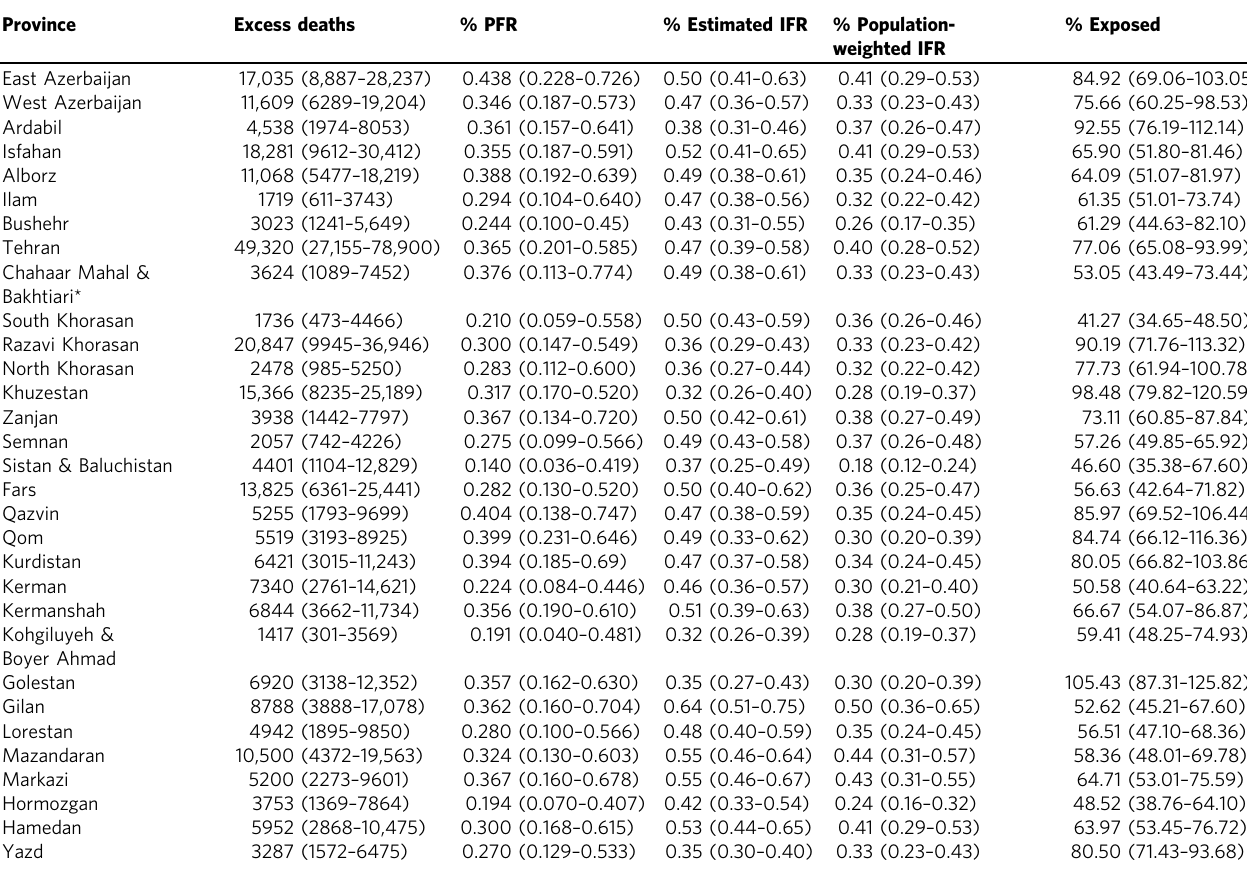
Table 1 The cumulative excess mortality, PFR, estimated IFR (estimated from the transmission model), population-weighted IFR (based on the age-distribution of each province), and percentage of the population ever exposed to SARS-CoV-2 in each province as of